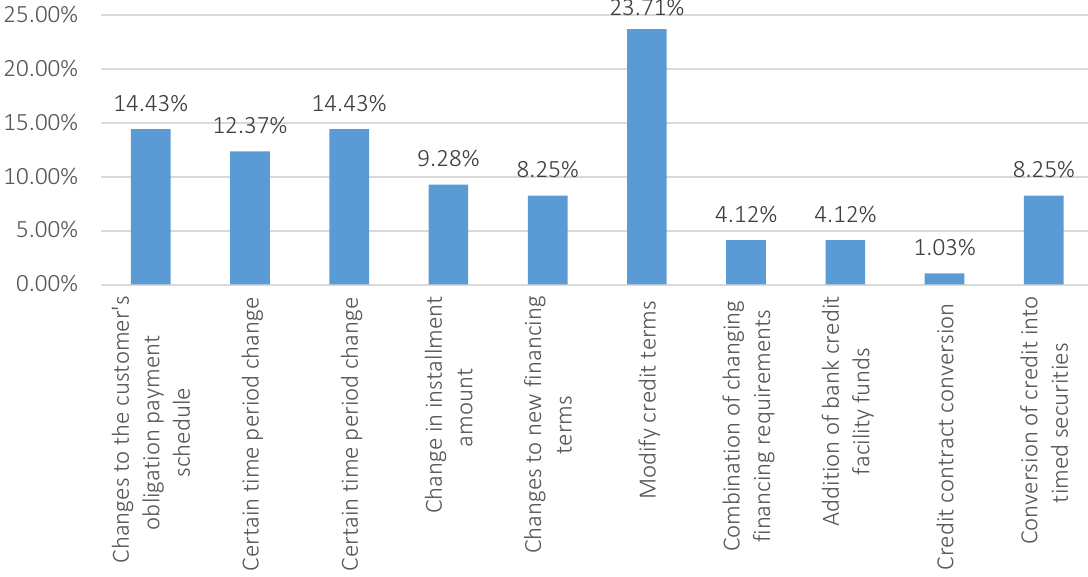
Figure 1. Bank loan